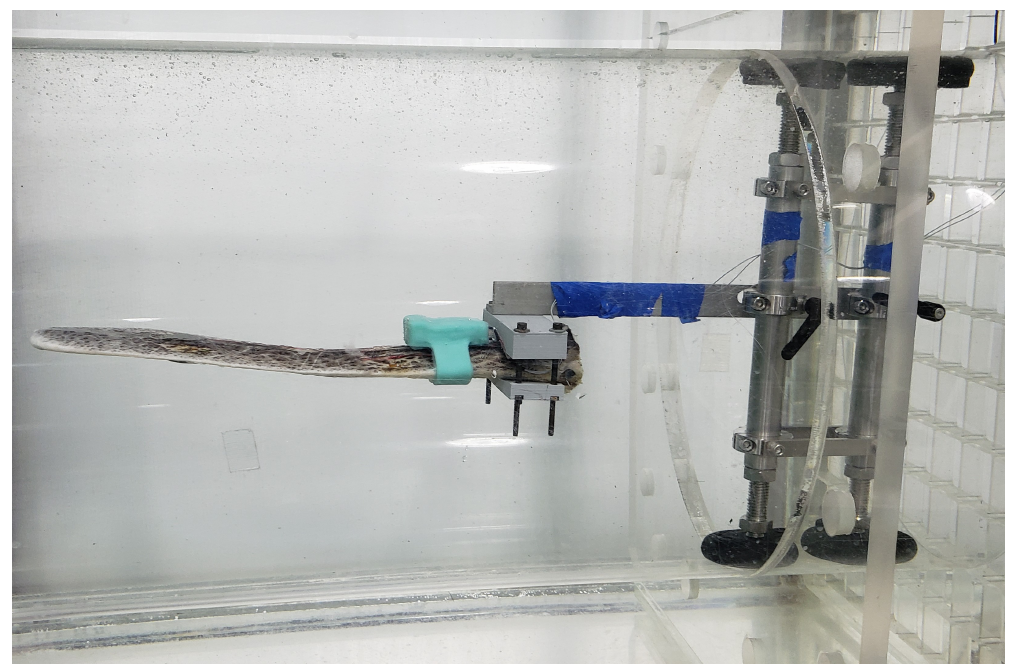
Figure 11. Eye-level view of rostrum mounted in the swim tunnel during